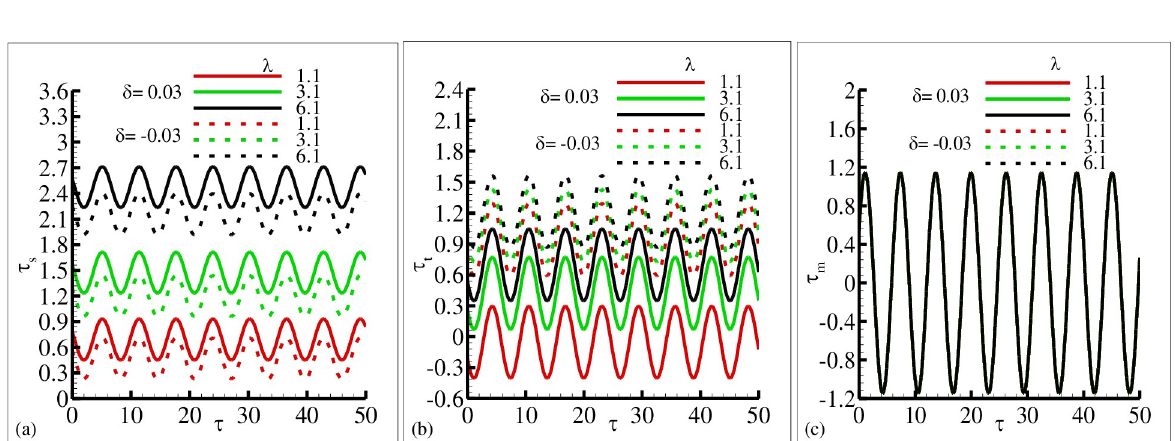
Fig 9. The graphical results of (a) τ parameters O = 1.7, ξ = 0.8, Pr = 7.0, and γ = 0.7.